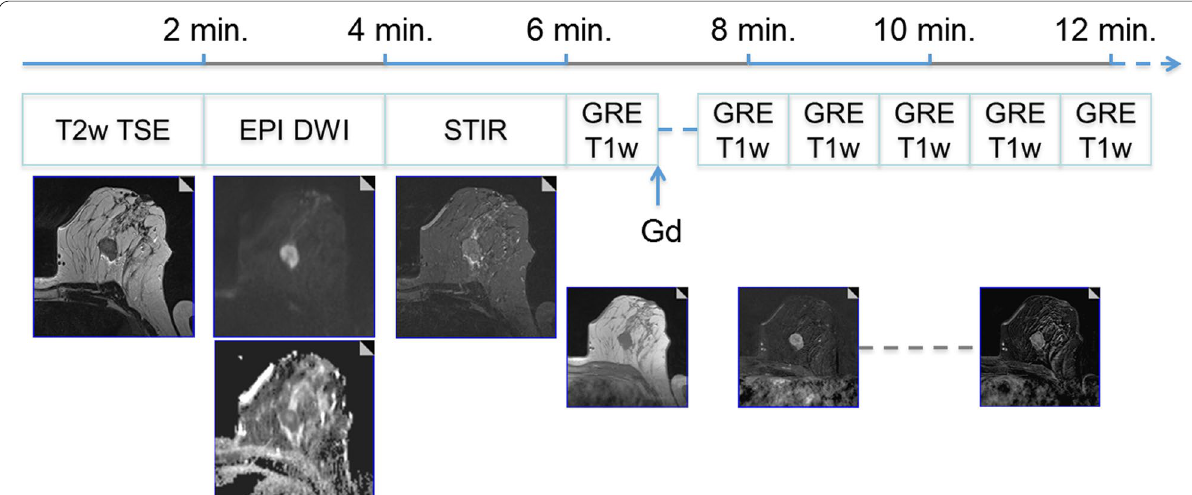
Fig. 1 A 15‑min clinical protocol for breast magnetic resonance imaging (MRI). All predictive/prognostic breast MRI information demonstrated in the next figures can be derived from a one‑stop shop clinical protocol as shown in this figure. The protocol starts with an unenhanced T2‑weighted turbo spin‑echo sequence (T2w TSE). Diffusion‑weighted imaging (DWI) and short‑tau inversion recovery (STIR) are optional but highly recommend. On T2‑weighted images, a mass lesion is diagnosed, with perifocal oedema. Next, contrast‑enhanced dynamic scanning is performed using a T1‑weighed gradient‑echo (GRE) sequence before/after the intravenous administration of 0.1 mmol/kg of a Gd‑based contrast agent. There is evidence of washout, perifocal oedema, and central necrosis (rim sign). The last two descriptors are imaging biomarkers associated with increased probability of high‑grade and nodal‑positive invasive cancers. Washout is a strong predictor of poor outcome and is associated with a higher likelihood of metachronous metastasis (see also Figs. 5 and 6). Example taken from ref [2], with permission (Dietzel et al. Insights Imaging